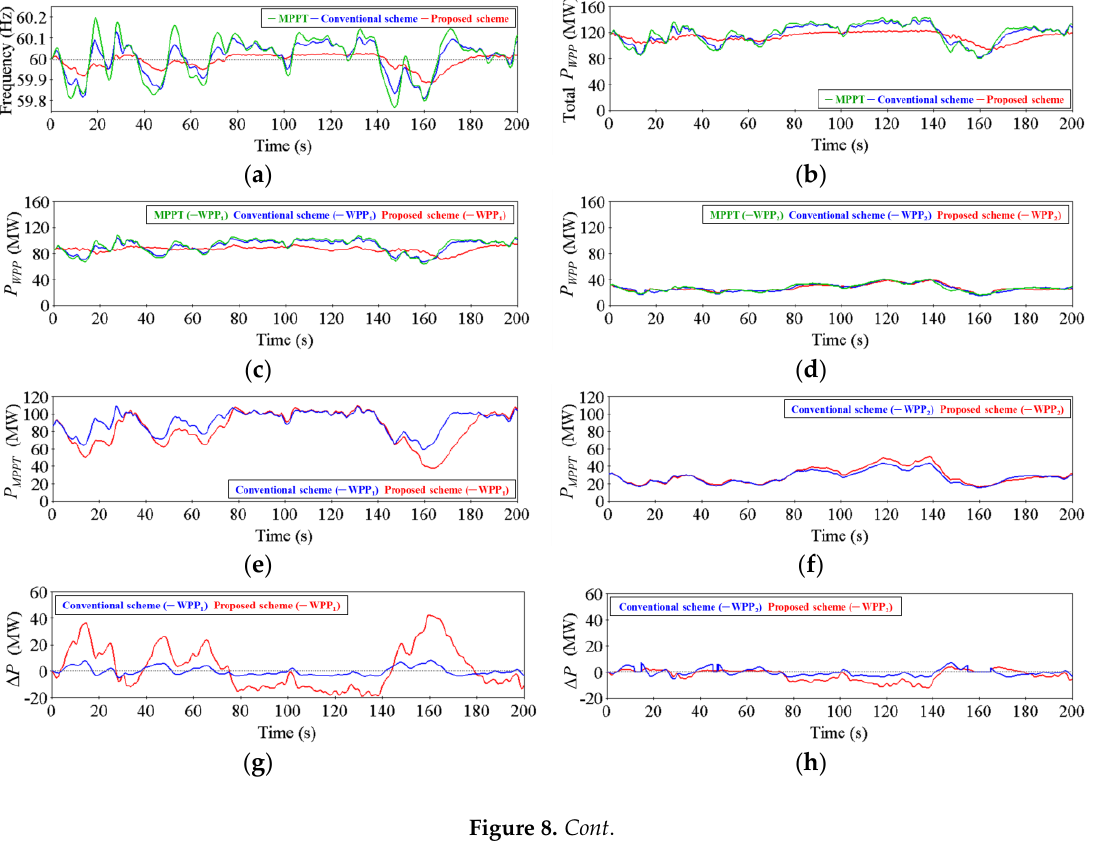
Table 2. Results for Case 2.